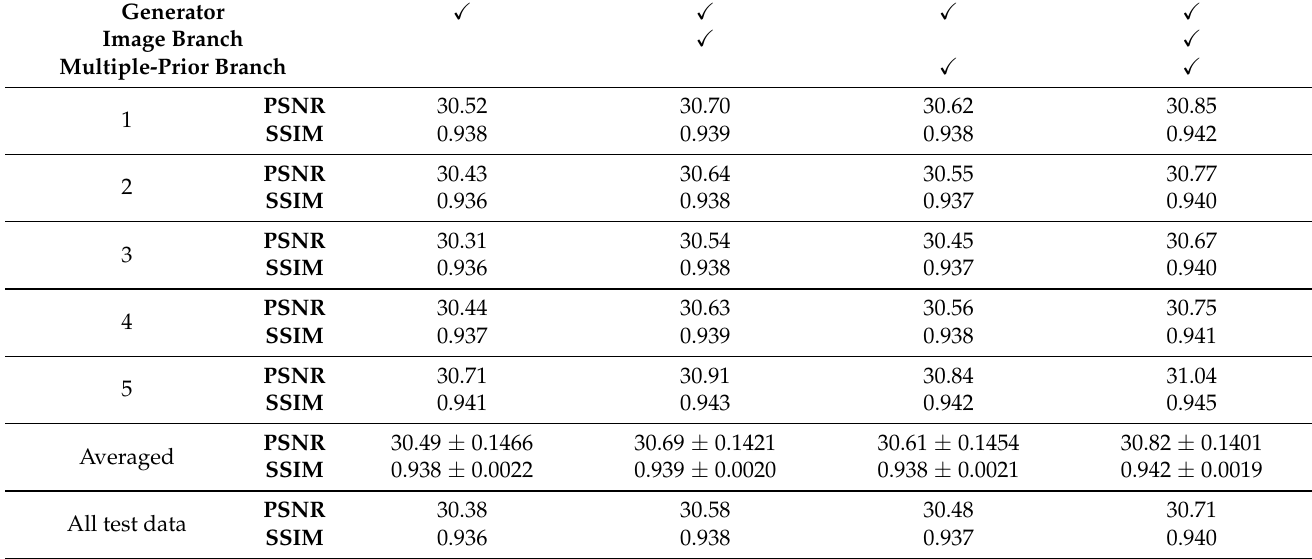
Table 1. Performance comparison of different components of DBSGAN.